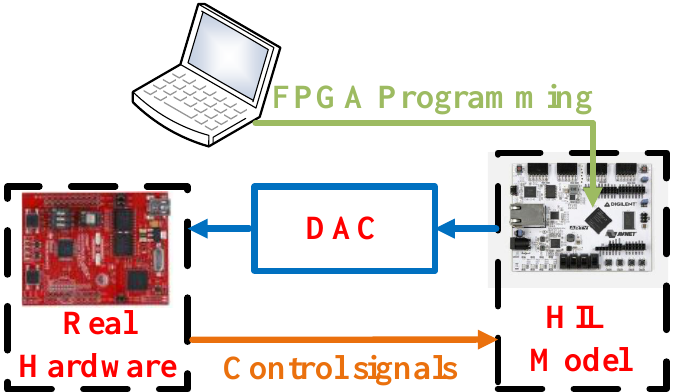
Figure 1. Basic elements of a general FPGA-based HIL